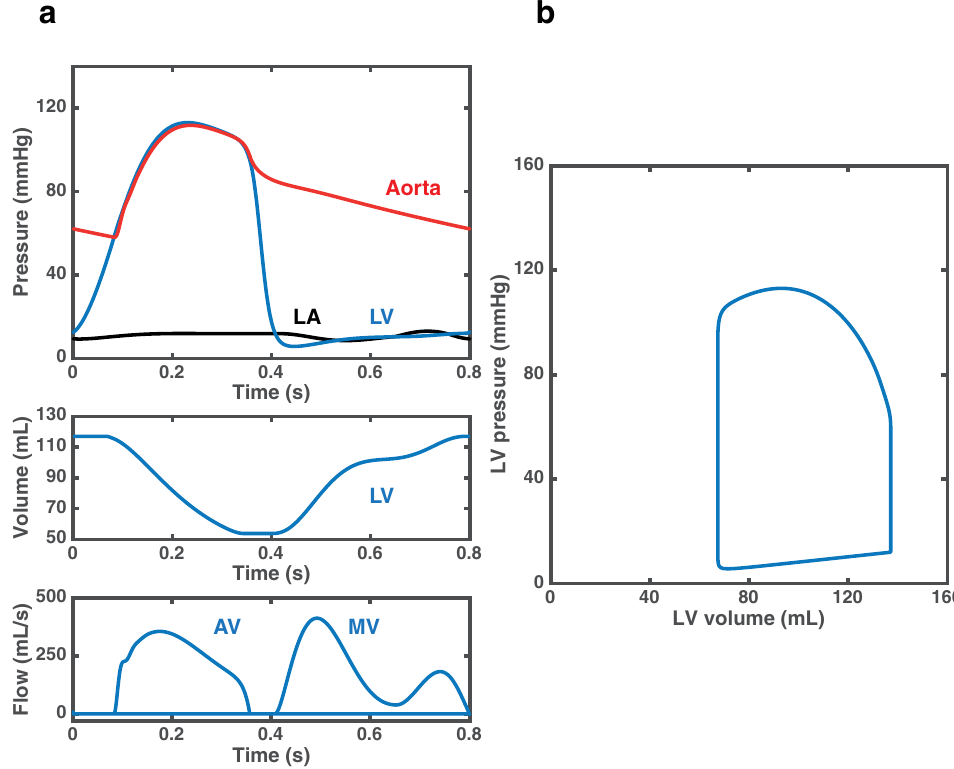
Figure 3. Model output including: ( a ) aortic root pressure (red), left ventricular pressure (blue), left atrial pressure (black) (top panel), left ventricular (LV) volume (middle panel) and flows through the mitral valve (MV) and the aortic valve (AV) (bottom panel); ( b ) left ventricular pressure-volume